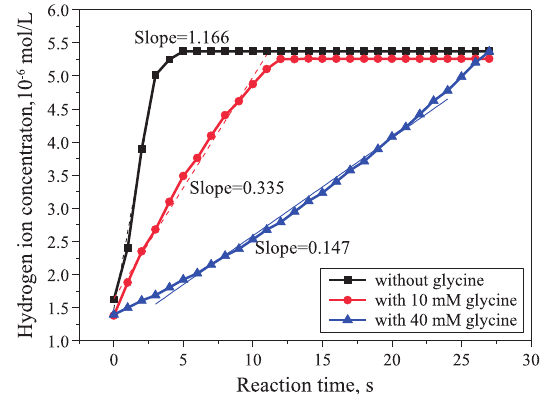
Fig. 2 The reduction rates of silver ions with the addition of glycine due to the stabilization of silver ions by com-